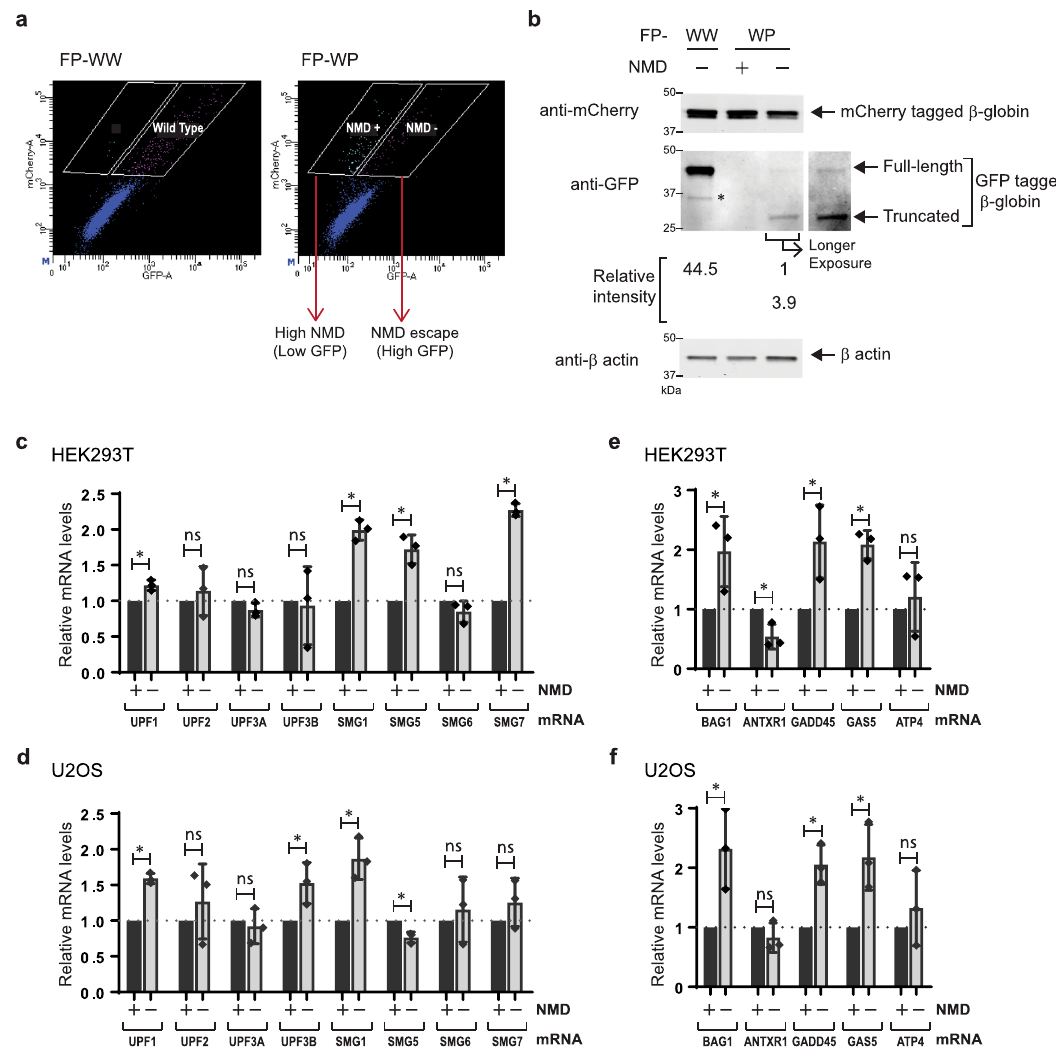
Fig. 5 Cell isolation correlated with NMD ef fi ciency. a Flow cytometric analysis of FP-WW or FP-WP expressing HEK293T PonA cells. Based on the mCherry and EGFP intensities in FP-WW expressing cell, the cell populations with distinct NMD ef fi ciency (NMD + ; higher NMD ef fi ciency, NMD − ; NMD escape) were determined and sorted using FACS. White boxes indicate the gate for cell isolation for FACS. Single dots denote fl uorescence intensities from single cells. b The EGFP and mCherry proteins expressed in isolated cell populations in a were detected in western blotting. The same number of cells isolated were loaded in each lane. EGFP-tagged wild-type β globin was detected in the fi rst lane (FP-WW). In contrast, no bands of EGFP- tagged β globin was detected in the second lane (ef fi cient NMD cell population (NMD + ) from FP-WP expressing cells). The differential intensities of EGFP bands between lower (truncated EGFP-tagged β globin) and higher (full-length EGFP-tagged β globin) indicated the frequencies of translation termination at PTC and readthrough. Relative intensities of EGFP bands are indicated under the blot detected with anti-GFP antibody. *Degradation product. β actin was detected as a loading control. c , d Quantitative mRNA detection of NMD regulators in NMD escape cells. Relative mRNA levels of NMD regulators in the cell population with NMD escape (NMD − ) compared to the cell population with ef fi cient NMD (NMD + ) in HEK293T ponA ( c ) or U2OS ponA cells ( d ) were determined by RT-qPCR using primers speci fi c for each transcript as indicated above each bar. P values were determined using two-tailed unpaired t-tests ( c ; p * = 0.0068 (UPF1), 0.5216 (ns, UPF2), 0.0867 (ns, UPF3A), 0.8421 (ns, UPF3B), 0.0003 (SMG1), 0.0033 (SMG5), 0.1523 (ns, SMG6), < 0.0001 (SMG7)), d ; p = 0.0001 (UPF1), 0.4240 (ns, UPF2), 0.6138 (ns, UPF3A), 0.0337 (UPF3B), 0.0067 (SMG1), 0.0054 (SMG5), 0.5841(ns, SMG6), 0.2609(ns, SMG7), ns = not signi fi cant). Error bars = Standard deviation from three independent experiments. e , f Relative mRNA levels of endogenous NMD targets in the cell population with NMD escape (NMD − ) compared to the cell population with ef fi cient NMD (NMD + ) in HEK293T ponA ( e ) or U2OS ponA cells ( f ) were determined by RT-qPCR using primers speci fi c for each transcript as indicated above each bar (BAG1; BCL2-associated athanogene 1 37,76 , ANTXR1; ADP Ribosylation Factor Related Protein 1 77 , GADD45; Anthrax toxin receptor 1 77 , GAS5; growth arrest speci fi c 5 77 , ATF4; activating transcription factor-4 4 . β actin (ACTB) was used as a control. P values were determined using two-tailed unpaired t tests ( e ; p * = 0.0464 (BAG1), 0.0186 (ANTXR1), 0.0353 (GADD45), 0.0014 (GAS5), 0.5634 (ns, ATP4), f ; p = 0.0274 (BAG1), 0.2974 (ns, ANTXR1), 0.0052 (GADD45), 0.0210 (GAS5), 0.4266 (ns, ATP4), ns = not signi fi cant). Error bars = Standard deviation from three independent